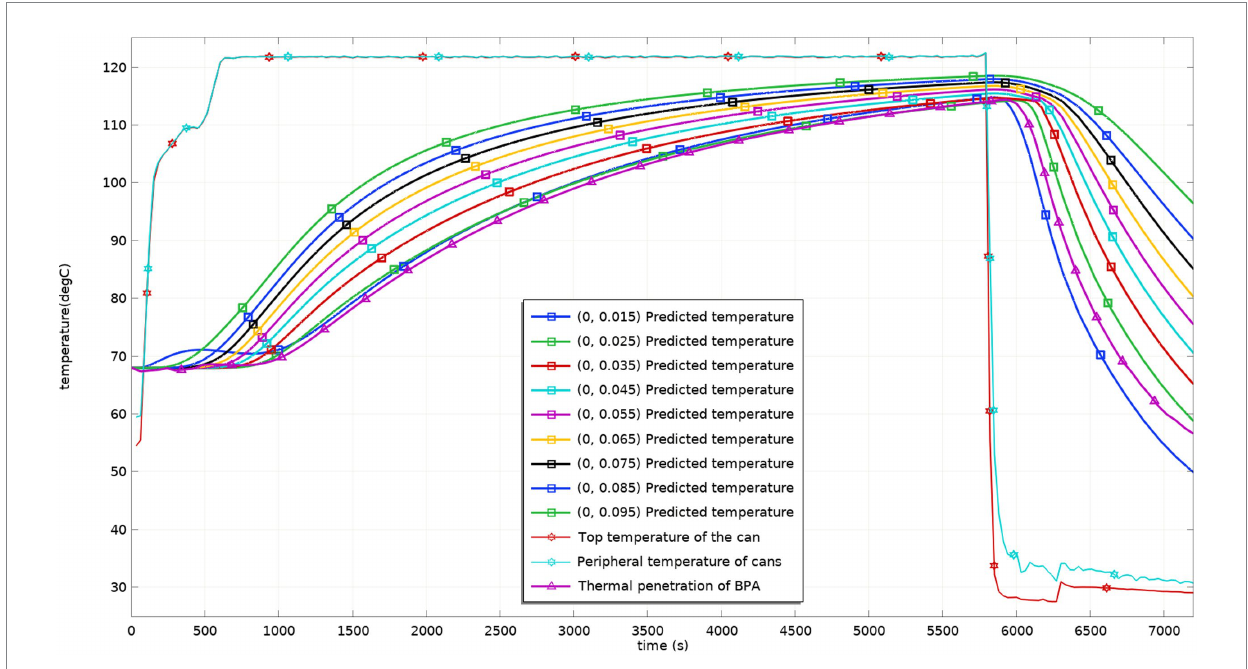
FIGURE. 5 Predicted and tested values of temperature at different heights in the can before process adjustment.